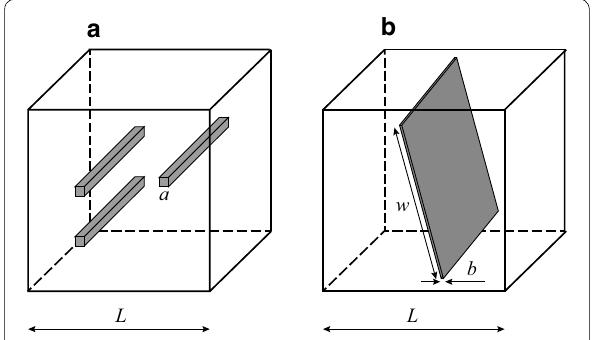
Fig. 9 Geometrical models of wide aperture parts ( a ) and narrow aperture parts ( b